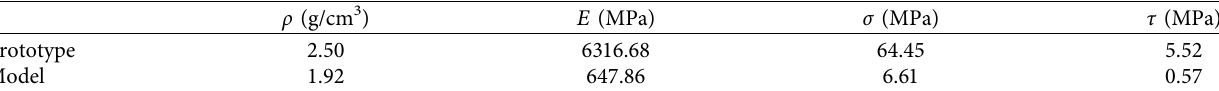
Figure 5: Stress-displacement curves and failure modes of splitting samples: (a) No. 6; (b) No. 7; (c) No. 8; (d) No. 9. Table 5: Target parameters of prototype and model.